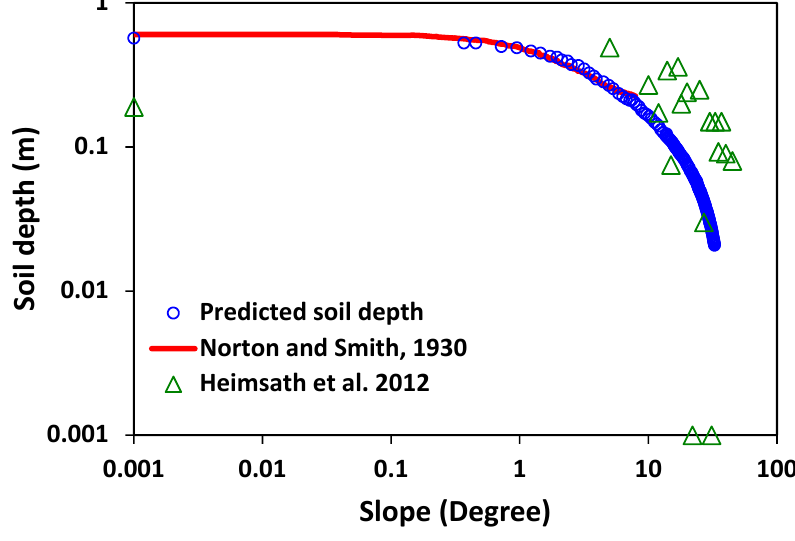
Figure 2. Predicted and observed soil depth as a function of slope. The Norton and Smith data were digitized from Jenny [10], but extend only to a slope of 8 degrees. The Heimsath et al. [45] data were reported in a Table and extend over the range of 6 degrees to 32 degrees. The erosion function input was digitized from Figure 1 of Montgomery and Brandon [60]. I was given in Table 1 here, and a